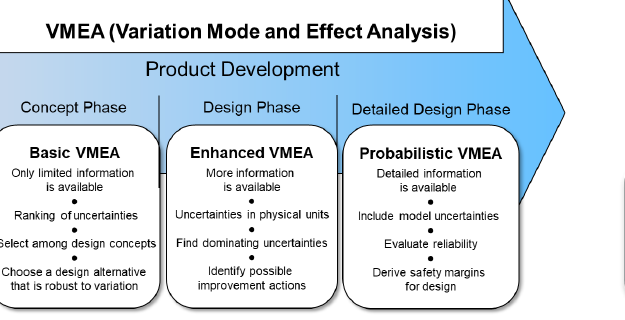
Figure 3: VMEA in different design phases. Fig. 2. VMEA in different design stages. From [19].